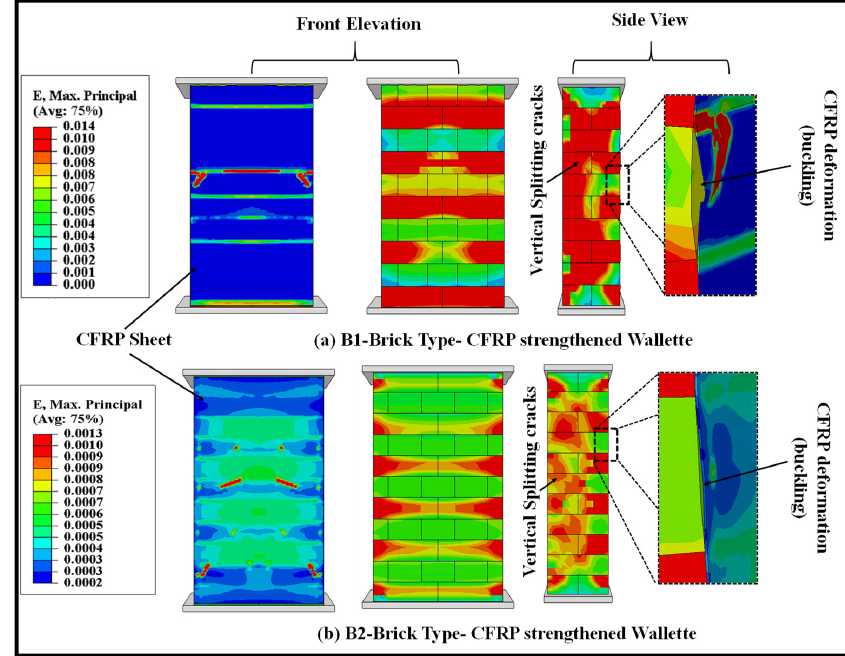
Figure 14. Numerically predicted damage on the surface of CFRP fabric and masonry wallettes constructed of different brick types; ( a ) B1 and ( b ) B2 under monotonic loading.